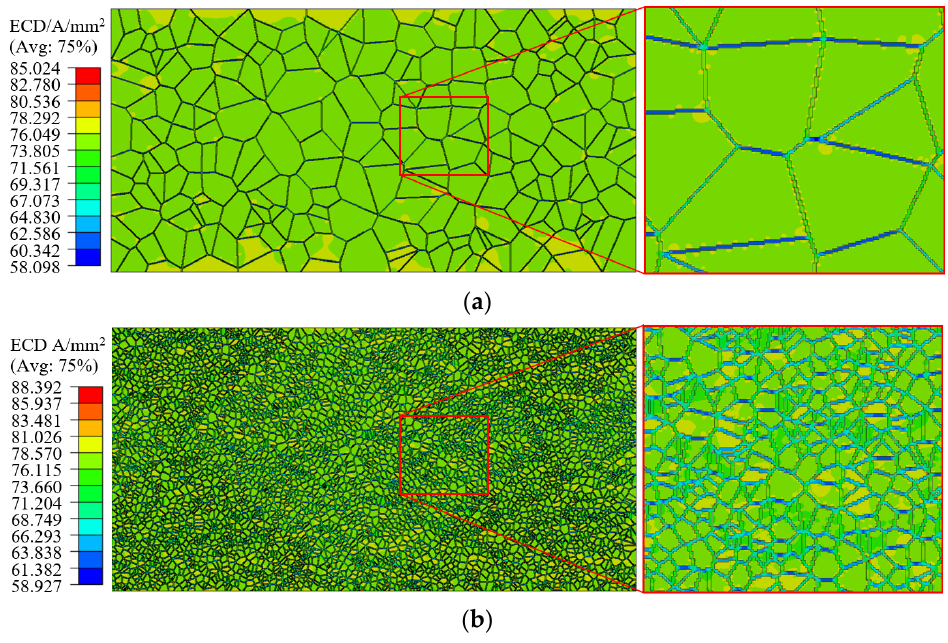
Figure 13. Distribution of ECD in polycrystalline under the electric current application in finite element analysis: ( a ) CG model; ( b ) FG model.